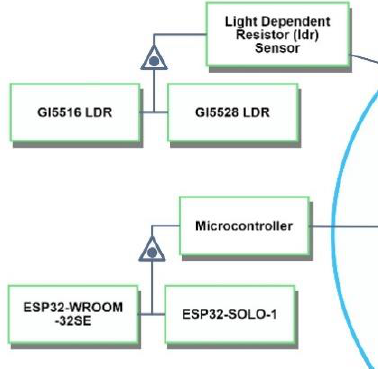
Figure 17. The system IoT devices instances.